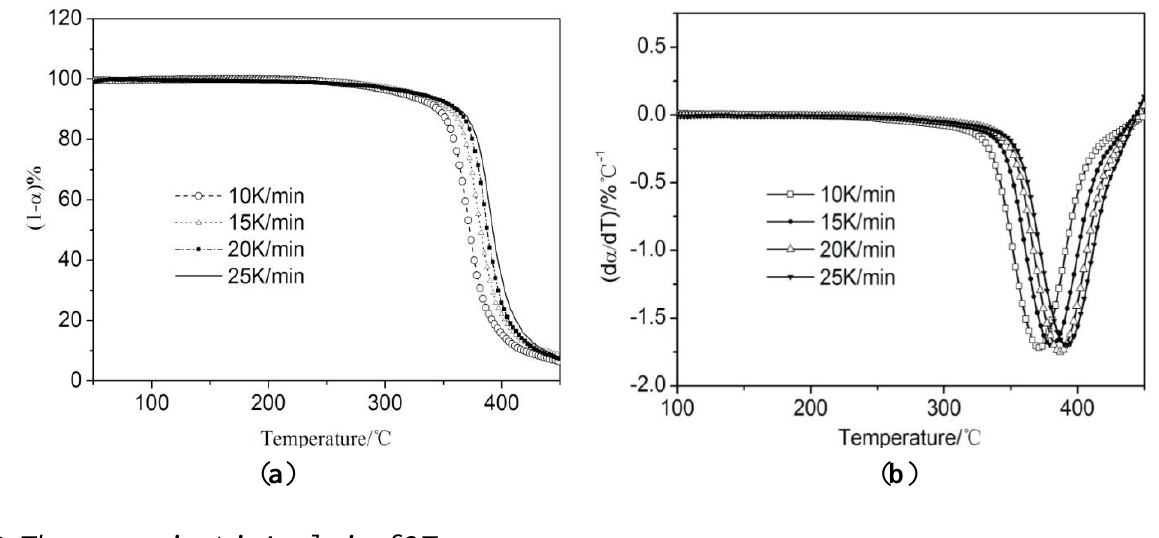
Figure 5. TG/DTG curves of ( a ) CTs and ( b )